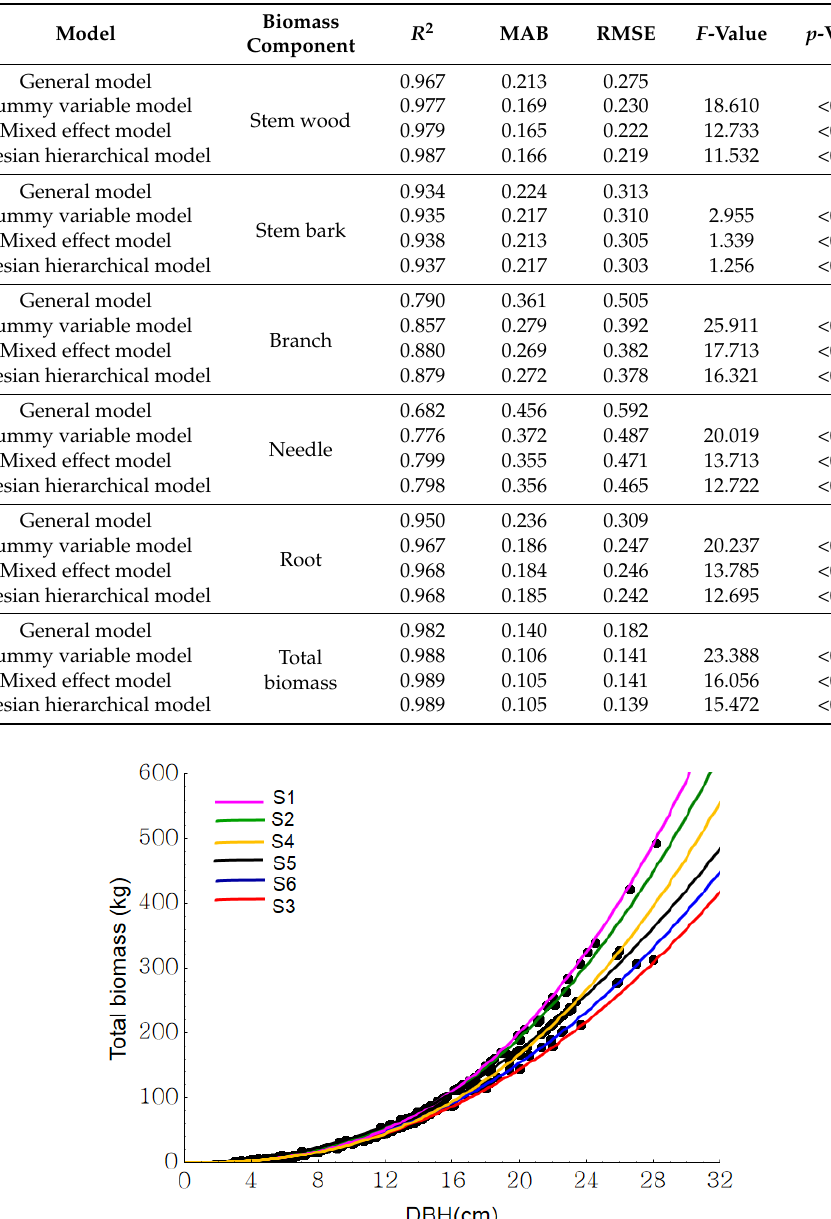
Figure 3. The regression curves of the linear mixed model for different regions.